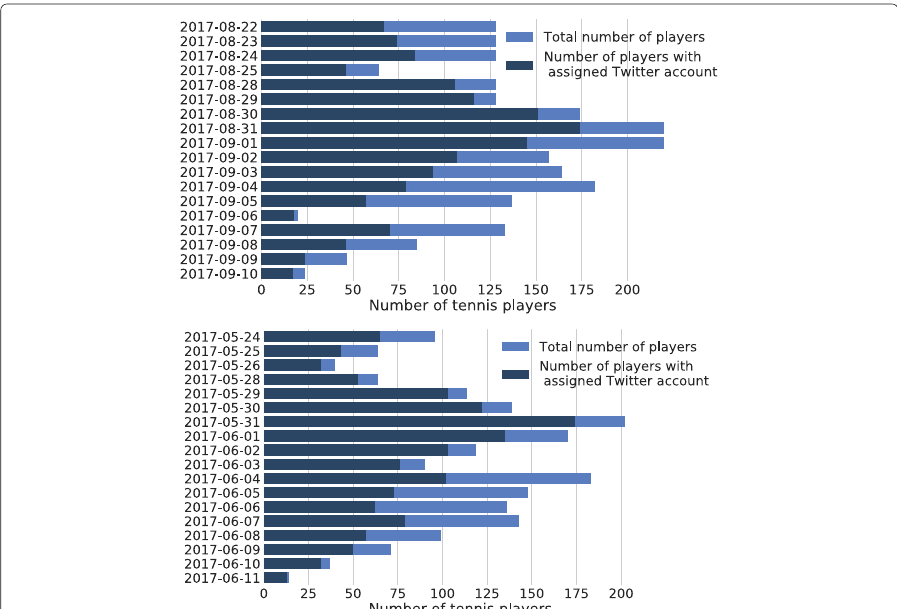
Fig. 7 The number of players active on a given day and the number of them with identified Twitter accounts. Top: UO17; bottom: RG17. Days with no tennis game between the qualifiers and the championship (Aug 26-27 and May 27, respectively) are not shown